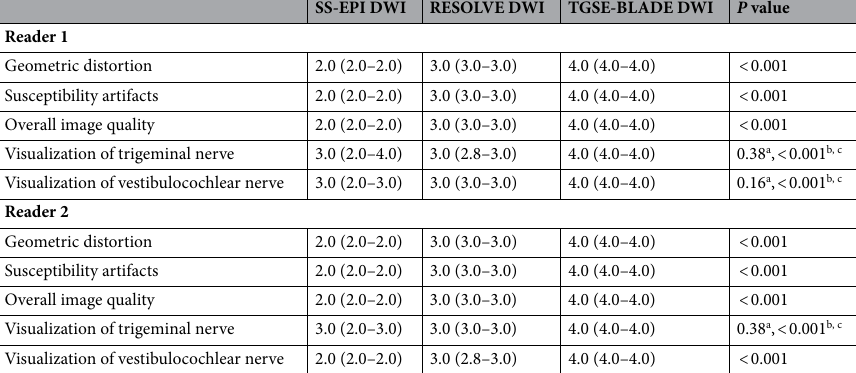
SS-EPI DWI RESOLVE DWI TGSE-BLADE DWI P